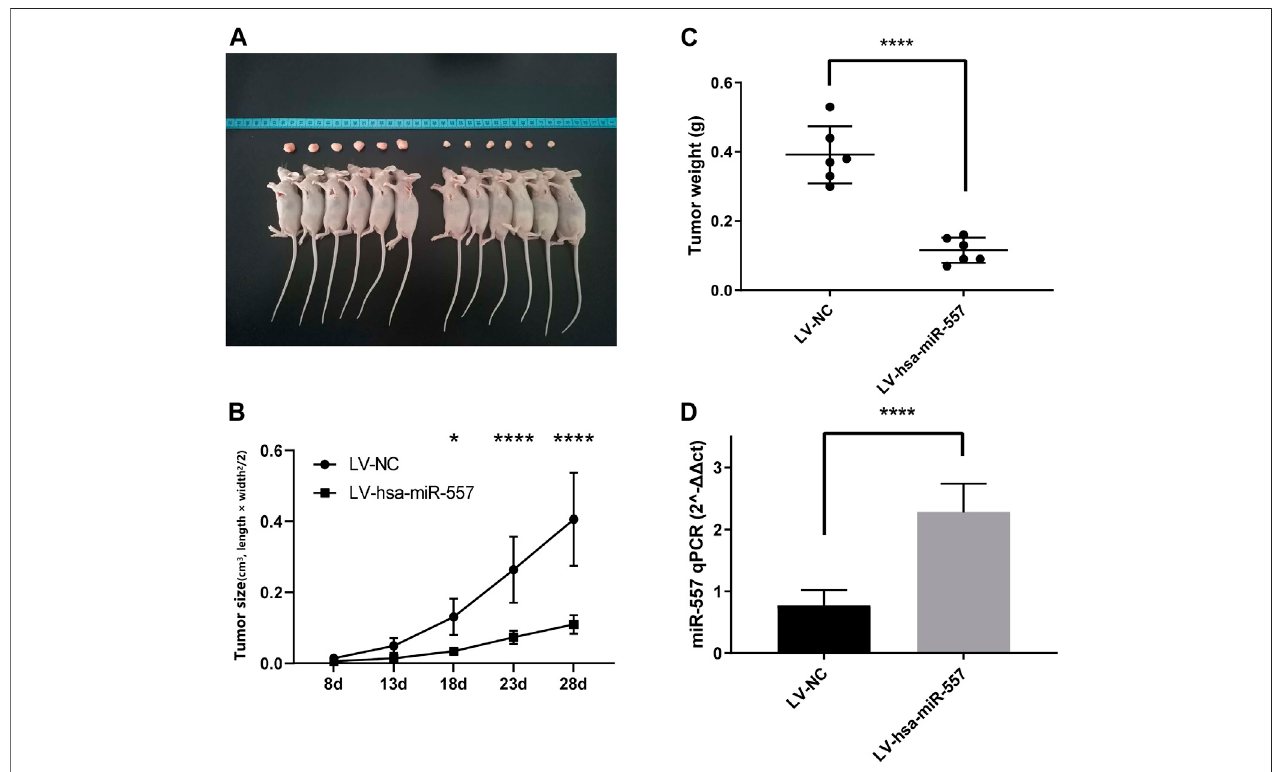
FIGURE 3 | Hsa-miR-557 inhibited the growth of osteosarcoma in vivo . MG63 cells transfected with hsa-miR-557 or the negative control (NC) by lentivirus (LV) wereinjectedintoBALB/cnudemicesubcutaneously. (A) Tumorsizesfromthehsa-miR-557groupandthenegativecontrolgroupafter28 days. (B) Tumorvolumewas measured every 5 days from the 8th day. (C) Signi fi cant lighter tumor weight was tested in the hsa-miR-557 group. (D) Higher levels of hsa-miR-557 expression in the hsa-miR-557 overexpression group were veri fi ed (* p < 0.05, **** p < 0.0001).